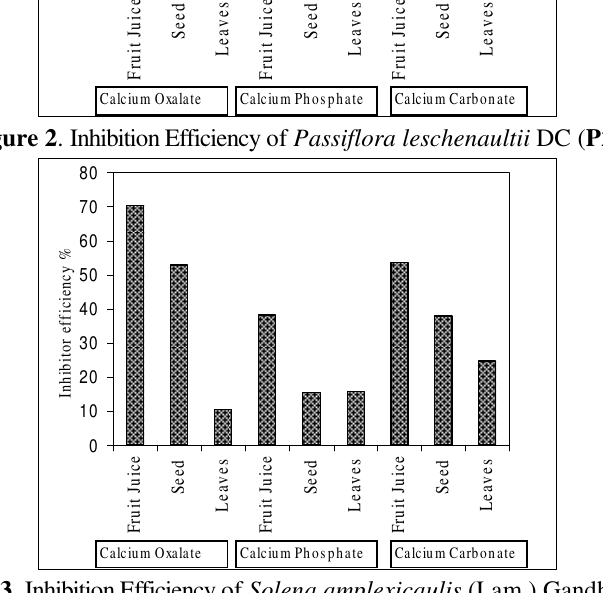
Figure 2 . Inhibition Efficiency of Passiflora leschenaultii DC ( P2 ).